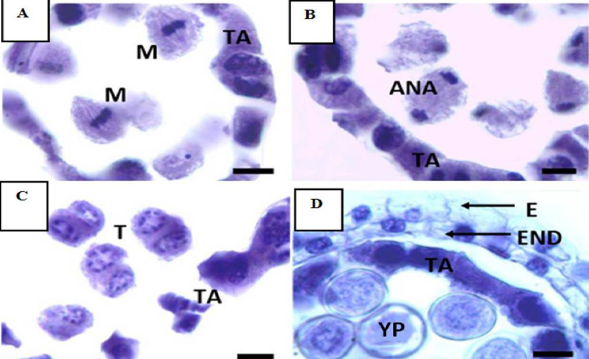
Fig. 4 . Anther wall layers at different developmental stages; A- At sporogenous tissue stage; B- At microspore tetrad stage; C- At young pollen stage; D- At mature pollen stage; ST: Sporogenous tissue, E: